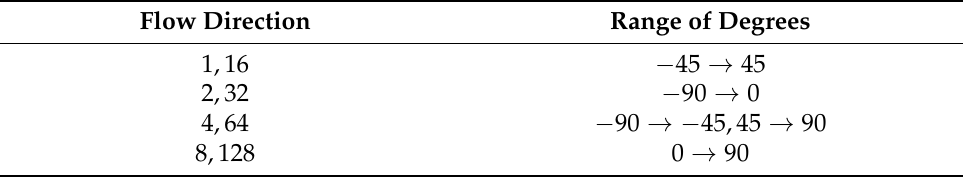
Figure 15. ( a ) To compute the angle of each found erosion pattern, each polygon was converted into a line (purple) and then theta was calculated; ( b ) Flow direction definition for the D8 method. Table 1. Range of angles that correspond to each flow